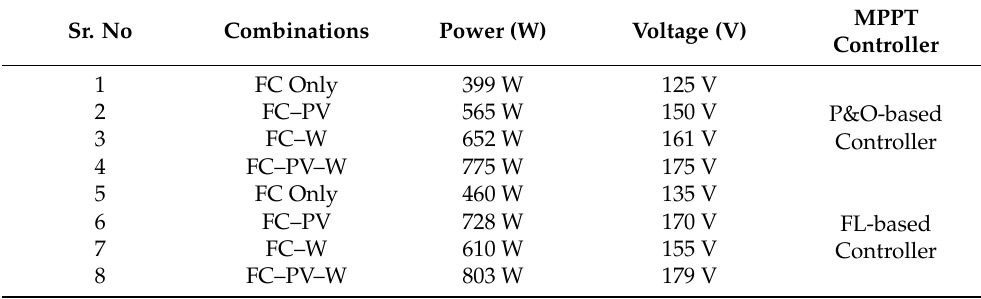
Table 5. Power and voltage comparisons in various combinations using different MPPT